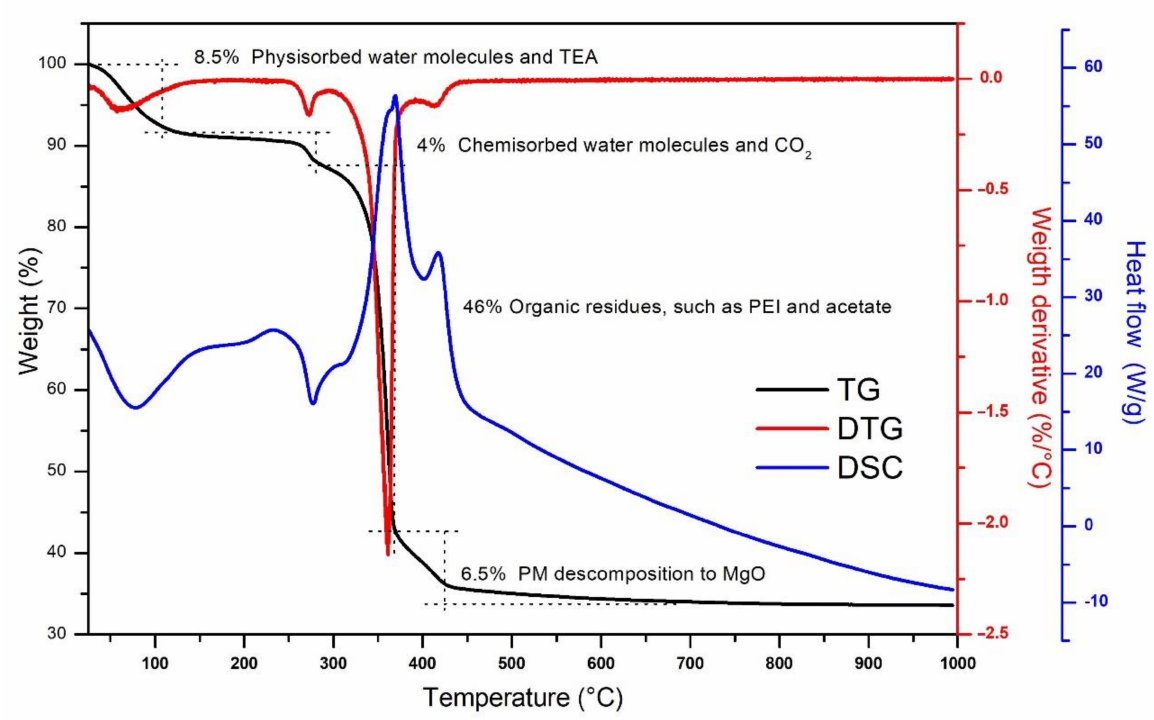
Figure 1. The precursor microparticles (PMs) thermogravimetric curve (TG, black curve), the first derivative of the TG (DTG, red), and the differential scanning calorimetry (DSC, blue) obtained in an extra-dry air